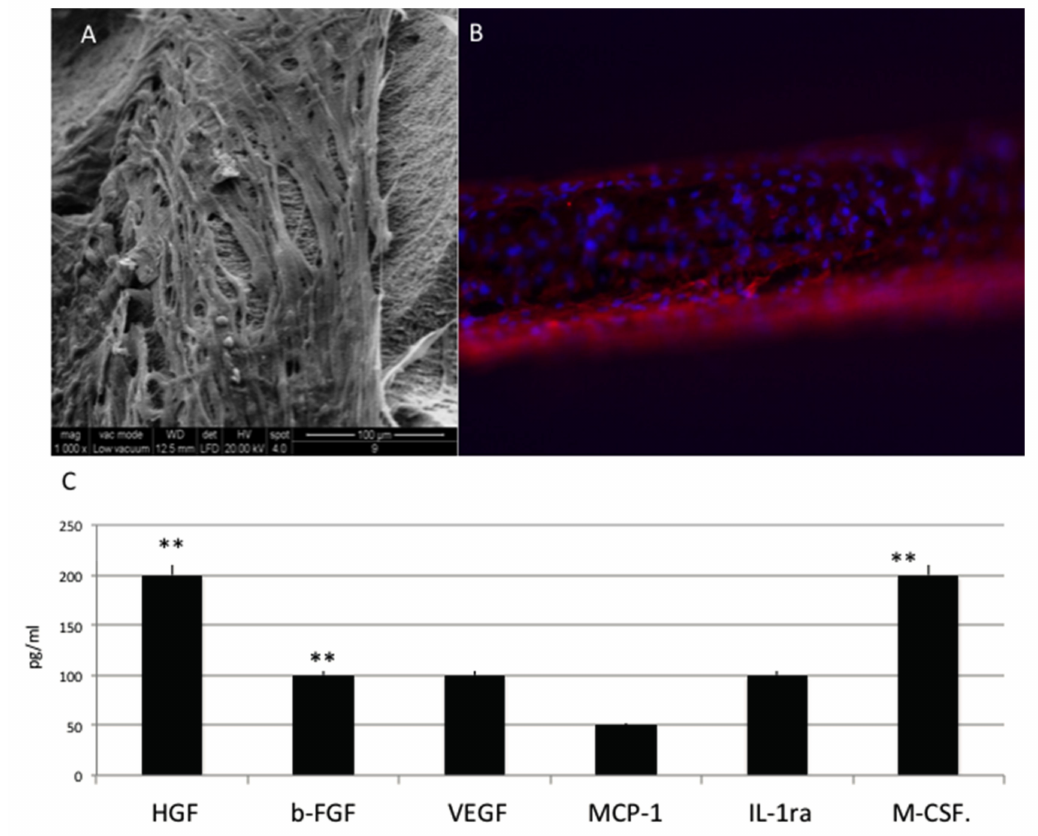
Figure 3. ( A ) SEM analyses of MSC in presence of osteoinductive medium cultured onto OGI surfaces; ( B ) immunohistochemical test against phalloidine (red) ( C ) Quantification of growth factor release pg/mL. Statistically significant differences are indicated as ** p <